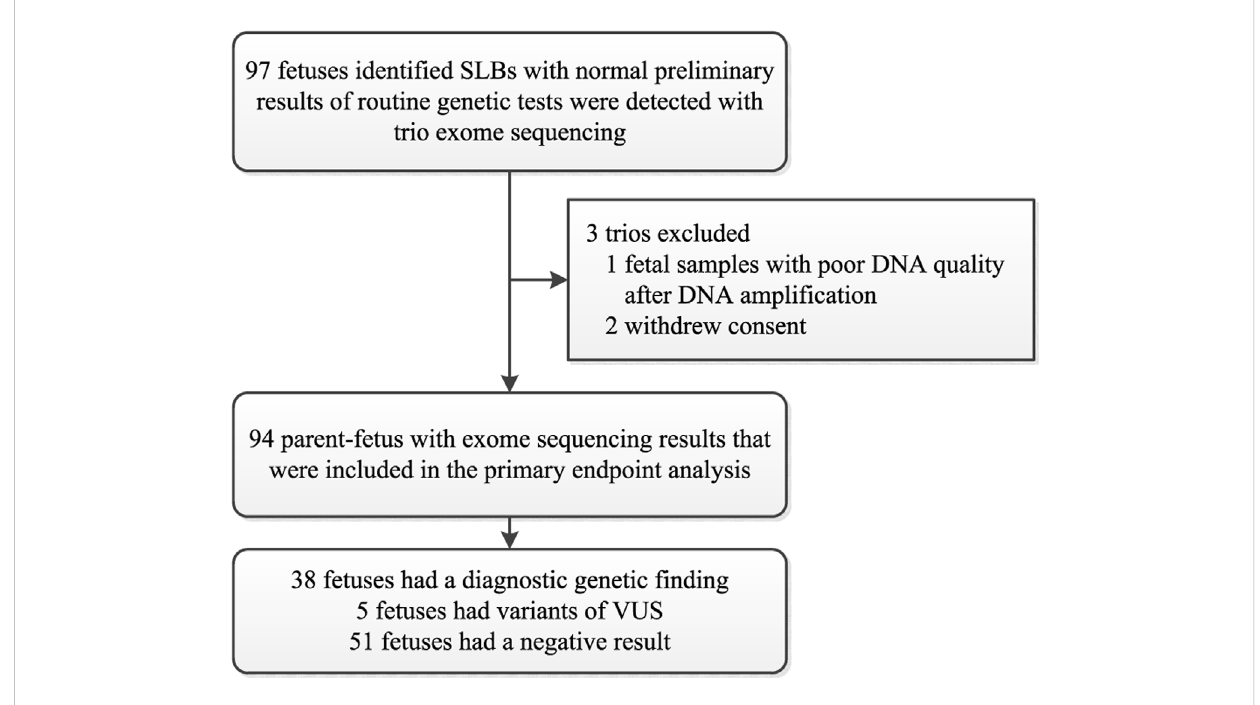
FIGURE 1 The fl ow diagram of the cohort and